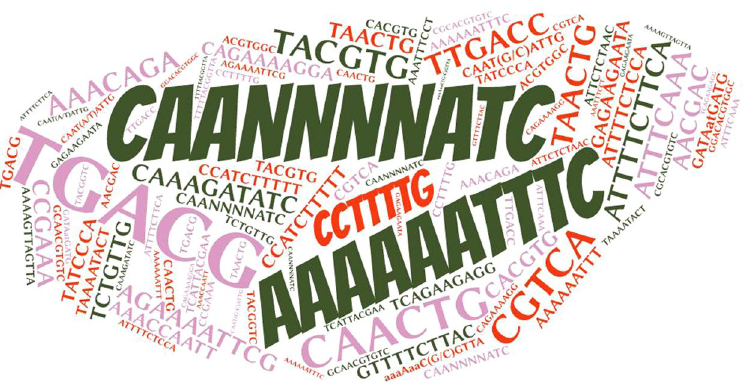
Figure 5. The word cloud image of promoter elements of 59 E2 ubiquitin conjugating enzymes. The size and intensity indicate frequency of the